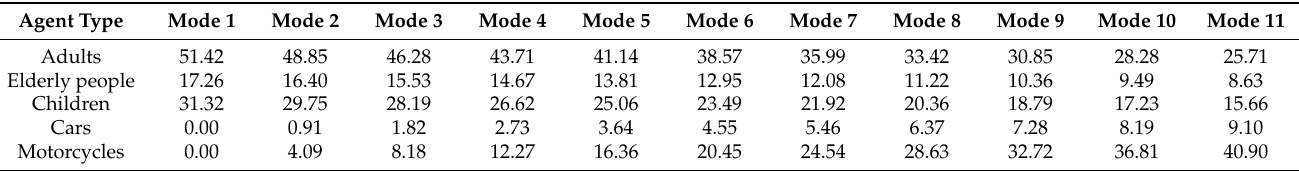
Table 1. Transportation mode choice